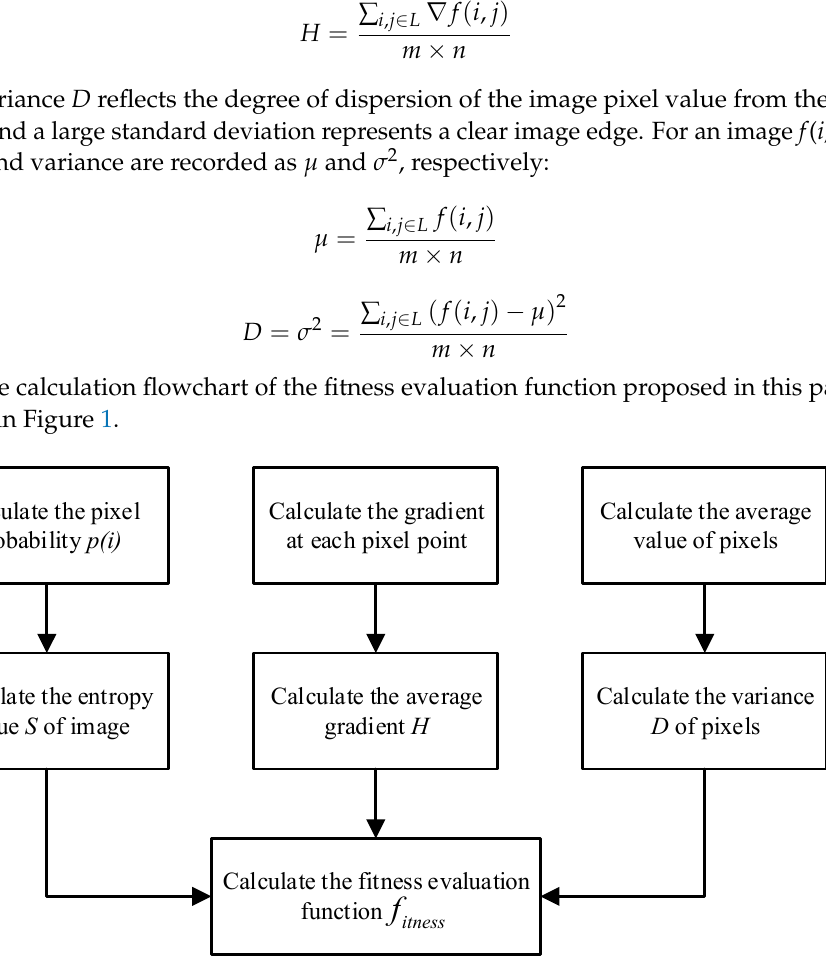
Figure 1. Flowchart of fitness evaluation function calculation.